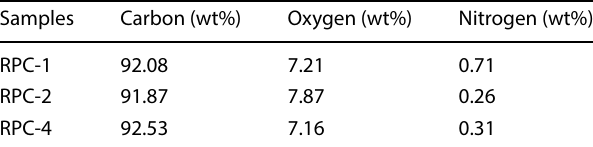
Table 2 EDX analysis of RPC samples